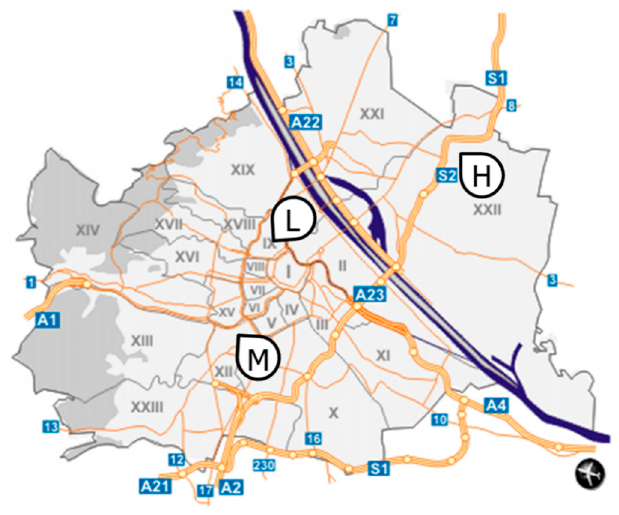
Figure 6. Map of Vienna [40] with sampling sites (L—low traffic volume; M—medium traffic volume; H—high traffic